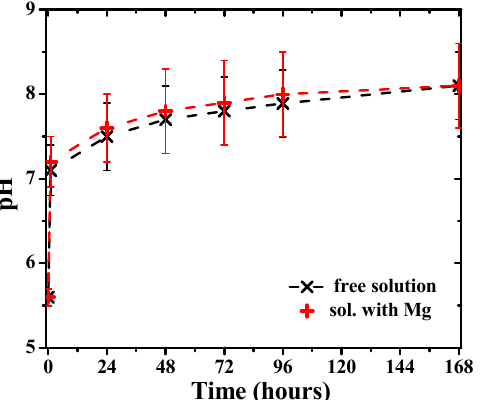
Figure 13. pH evolution of the carbonated water solution in the presence of Mg disks and without them (free solution).